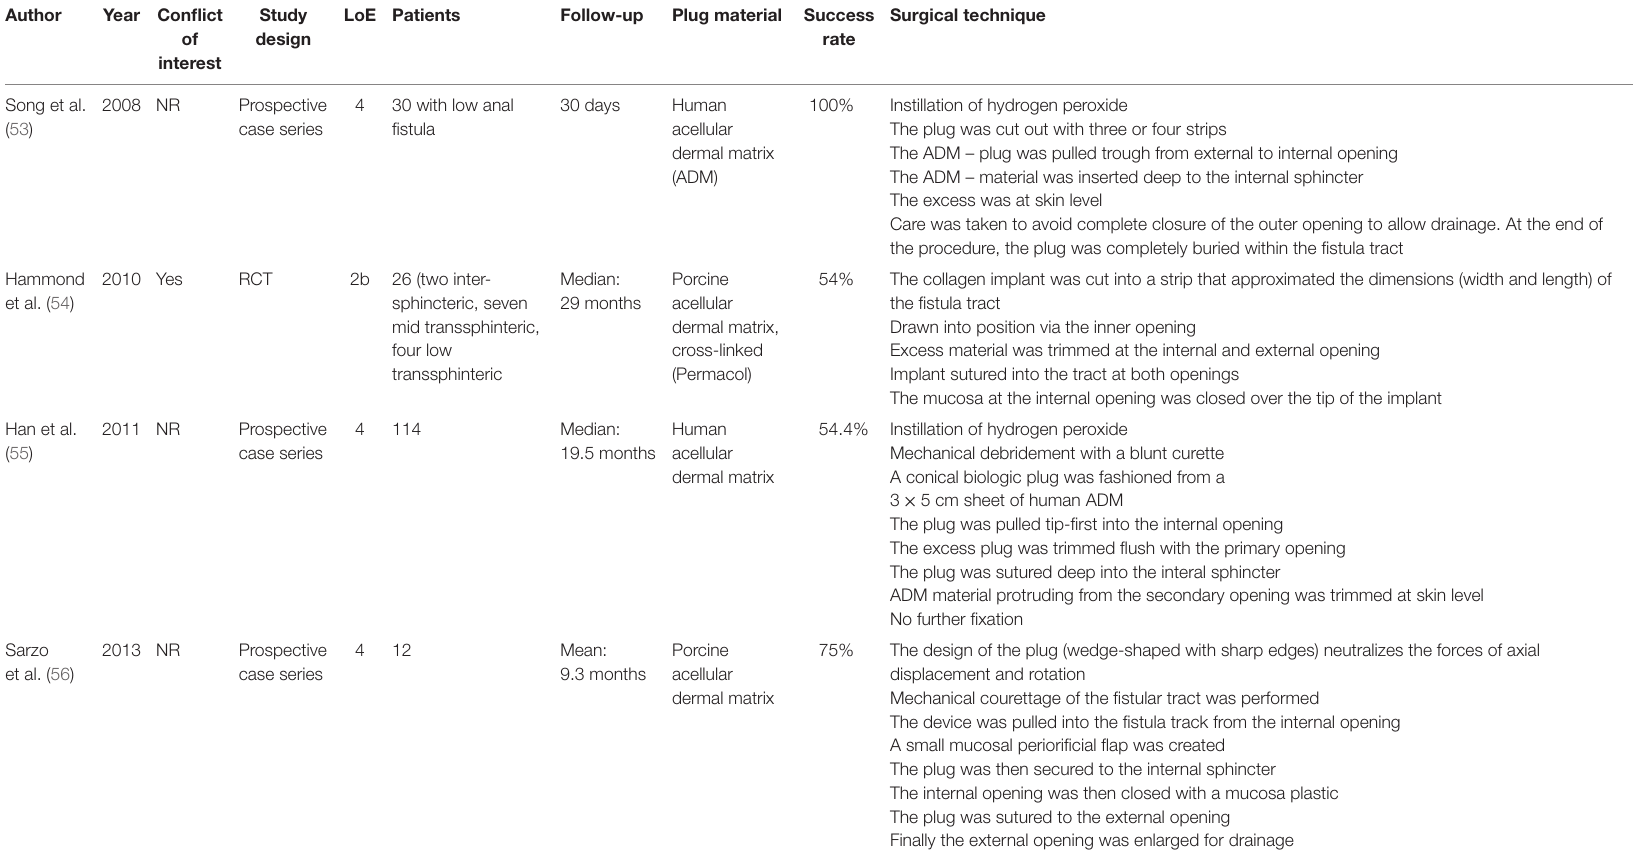
TABLe 5 | Case series of complex anal fistula repair with acellular dermal